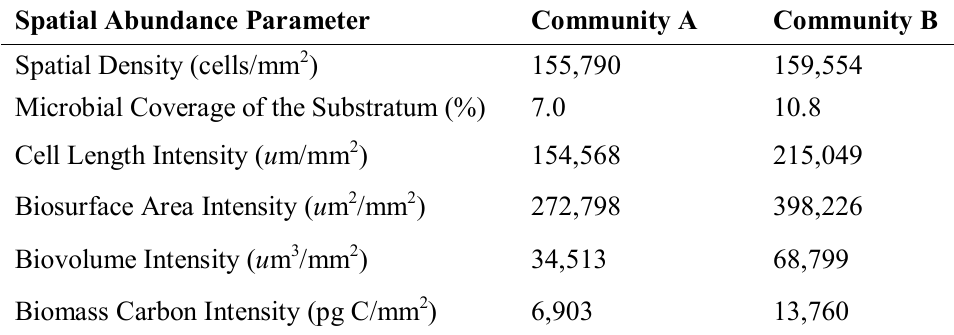
Table 1. Spatial intensity in microbial community A and B freshwater biofilms developed for four days on plain glass and polystyrene substrata (Figure 1a,b),